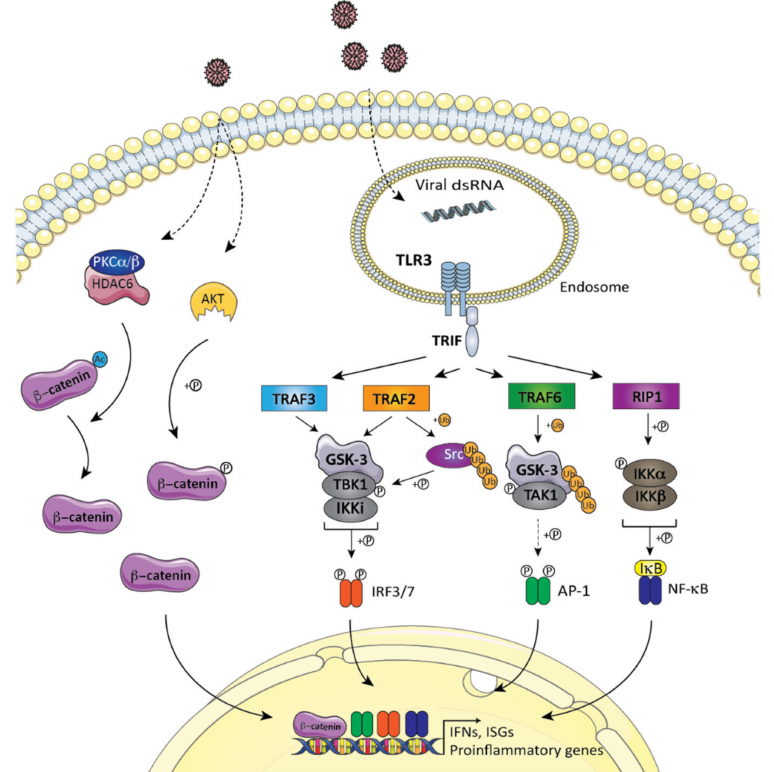
Figure 6. GSK-3 / β -catenin in endosomal nucleic acid sensing by TLR3. The engagement of dsRNA molecules with TLR3 triggers activation of TRIF adaptor, which sca ff olds the TRAF6-TAK1, RIP1-IKK, and TRAF3-TBK1 complexes, thus leading to the activation of the AP1, NF- κ B, and IRF3 transcription factors, respectively, to produce pro-inflammatory cytokines and type I IFN. Catalytically inactive GSK-3 β acts as a signaling platform required for TRIF-mediated downstream signaling following